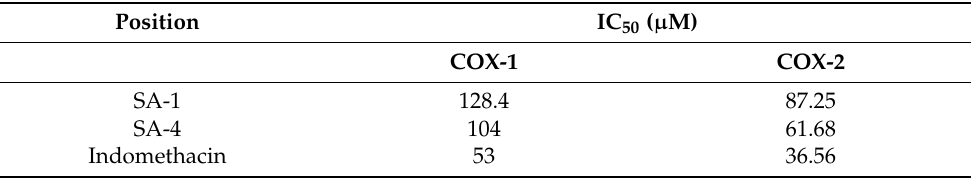
Table 3. IC 50 of the synthesized compounds by in vitro COX-1 and COX-2 enzymatic assay and COX-2.